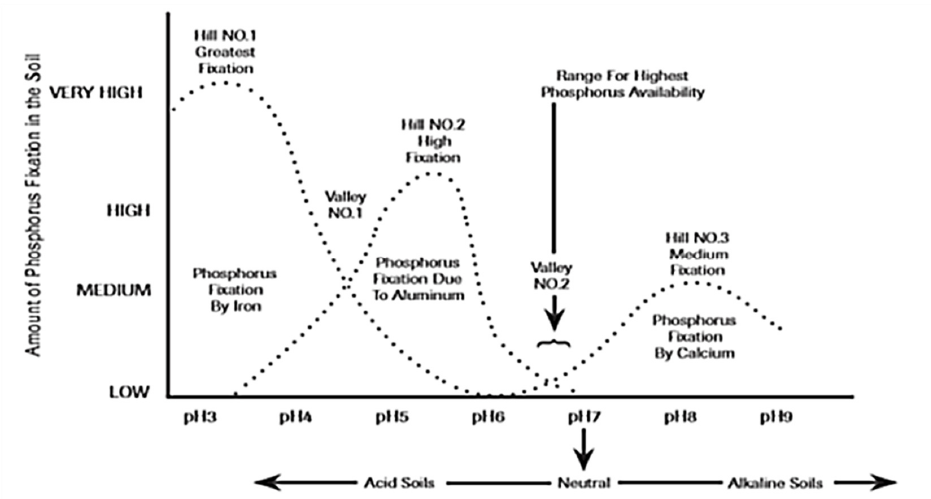
Figure 3. Phosphorus fixation subject to pH Source: